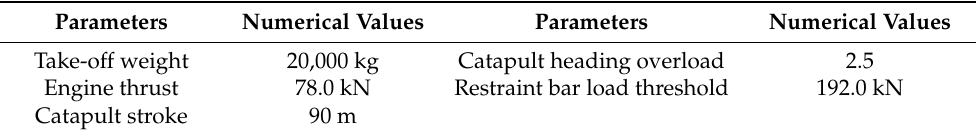
Table 3. Catapult dynamics model parameters.